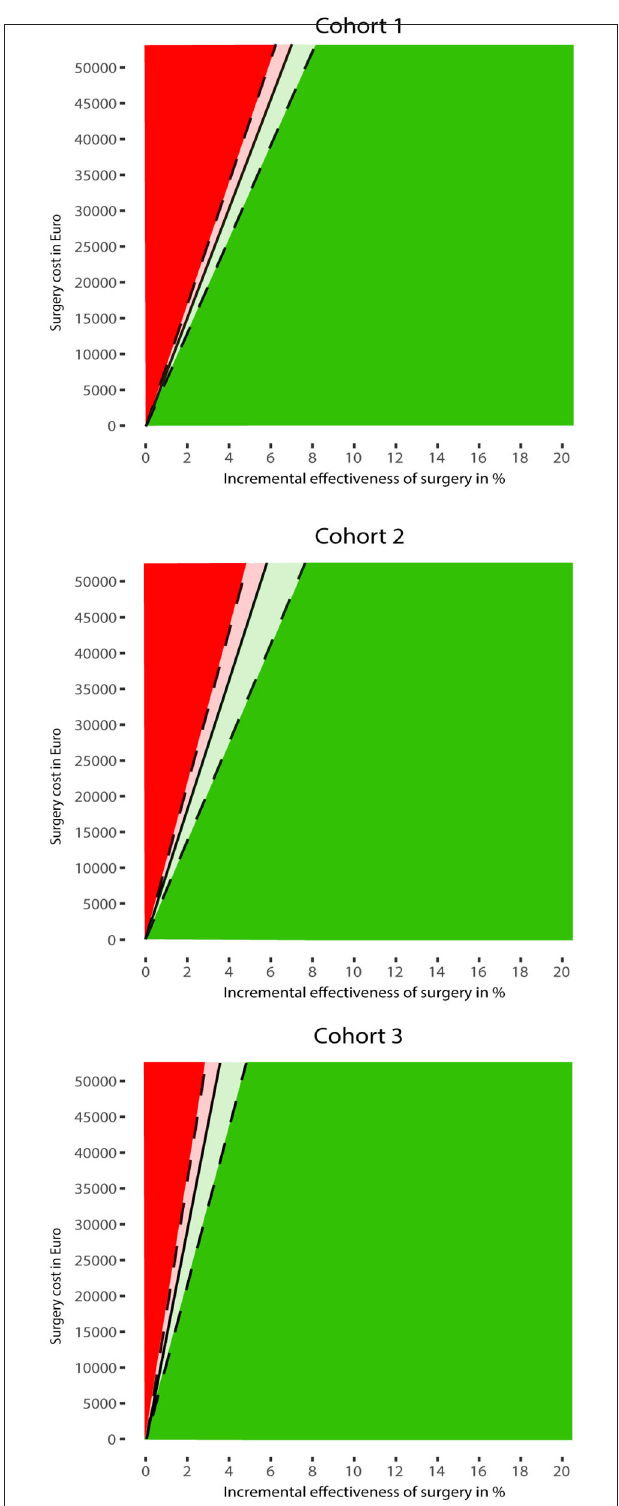
FIGURE 3 | Results of the two-way sensitivity analyses. The MIS strategy is potentially most cost-effective for combinations of surgery cost and effectiveness in the green area. The red area indicates when usual care is most cost-effective. The effectiveness of MIS was assumed to be an absolute